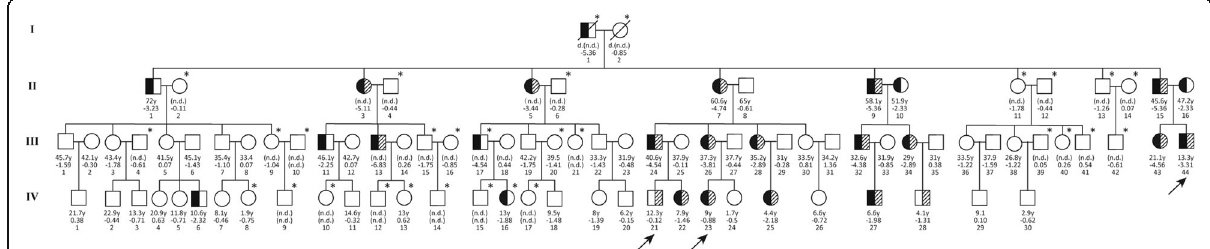
Fig. 1 The family pedigree of members with and without the ACAN p. Gln2364Pro variant. Age and height are listed below each symbol. Black arrows: three children whose bloods were performed WES. Half-black symbols: family members with short stature (height < -2SD). Half-shaded symbols: family members carrying the ACAN mutation. An asterisk next to a symbol indicates that a blood sample was unavailable. A slash with a symbol indicates that the individual is deceased. n.d.: not